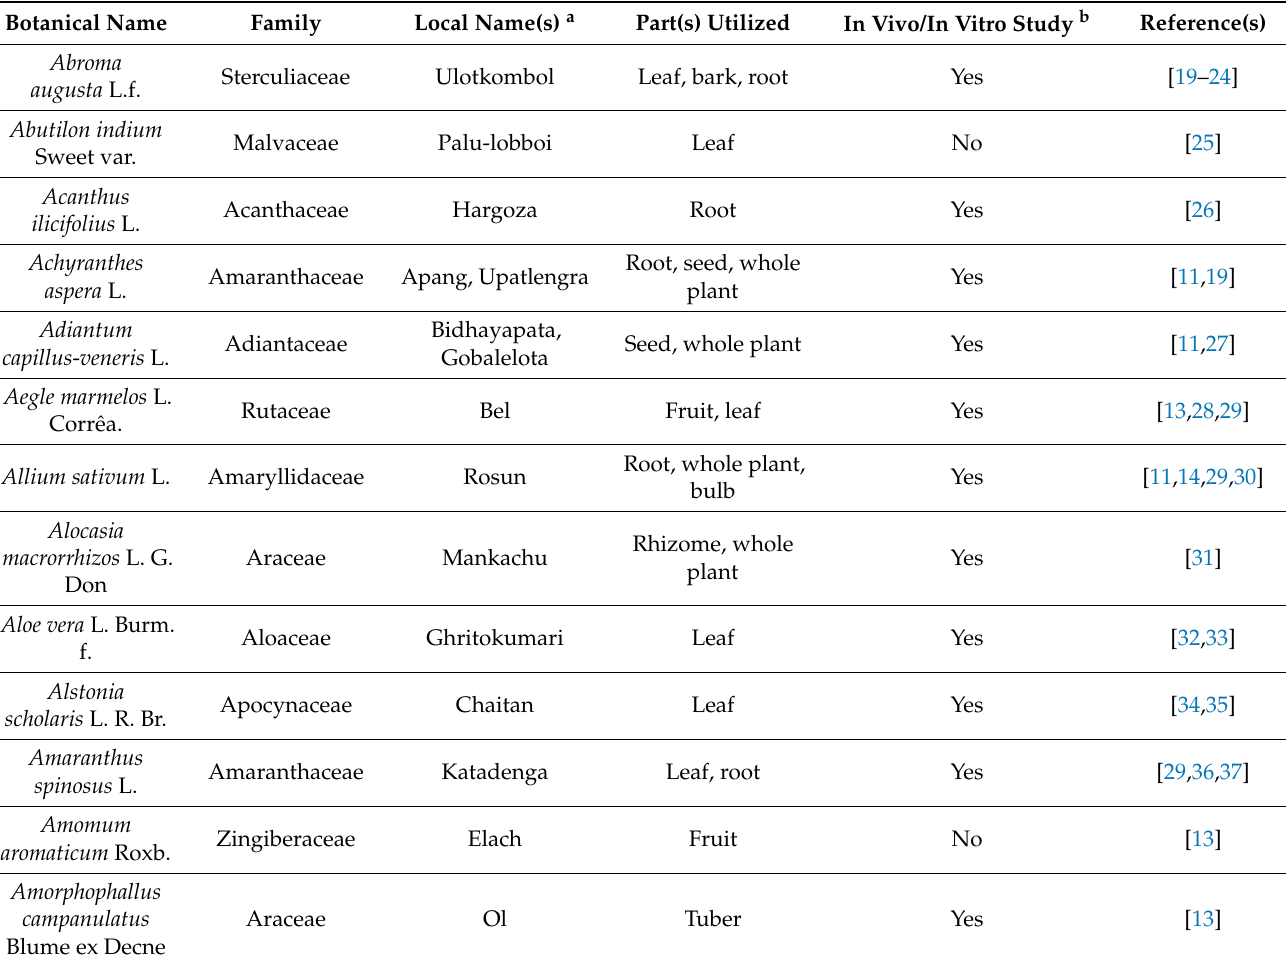
Figure 1. Percentage of parts of antidiabetic plants used for the treatment of diabetes in Bangladesh. Percentages were calculated as the ratio between the number of plant parts used belonging to a certain family and the total number of plants. Table 1. List of ethnomedicinal plants used for the treatment of diabetes in